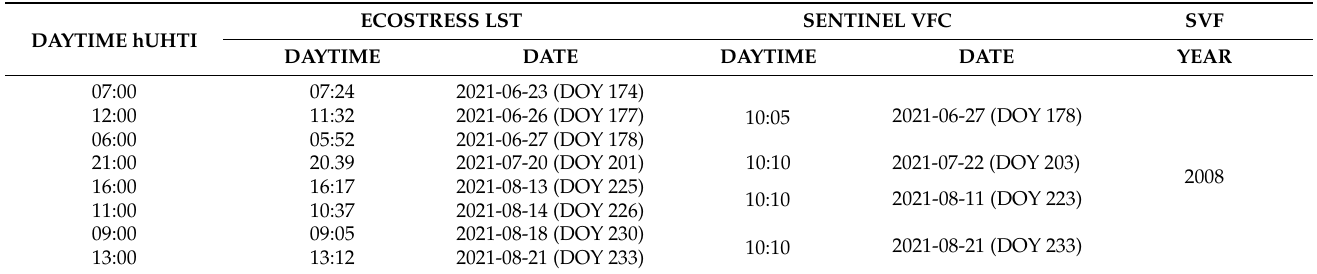
Table 4. List of the hUHTI maps calculated in the present investigation and the remotely sensed input layers used for their